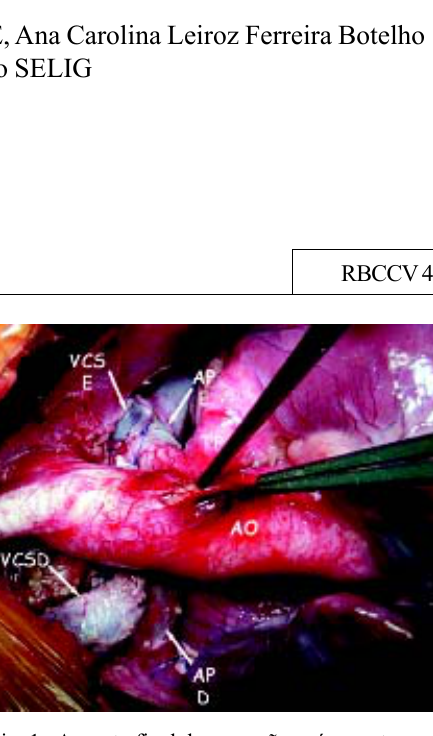
Fig. 1 - Aspecto final da operação após anastomoses da veia